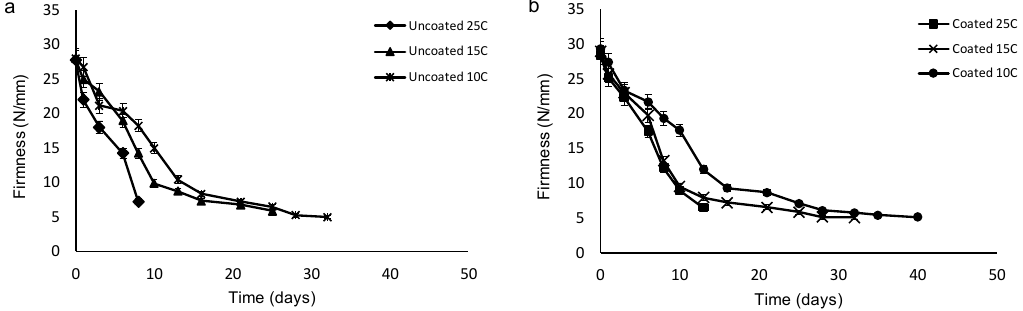
Figure 8. Changes in firmness of coated and uncoated limes during storage at different temperatures. Table 6. Kinetic parameters for firmness changes of coated and uncoated limes stored at different temperatures.